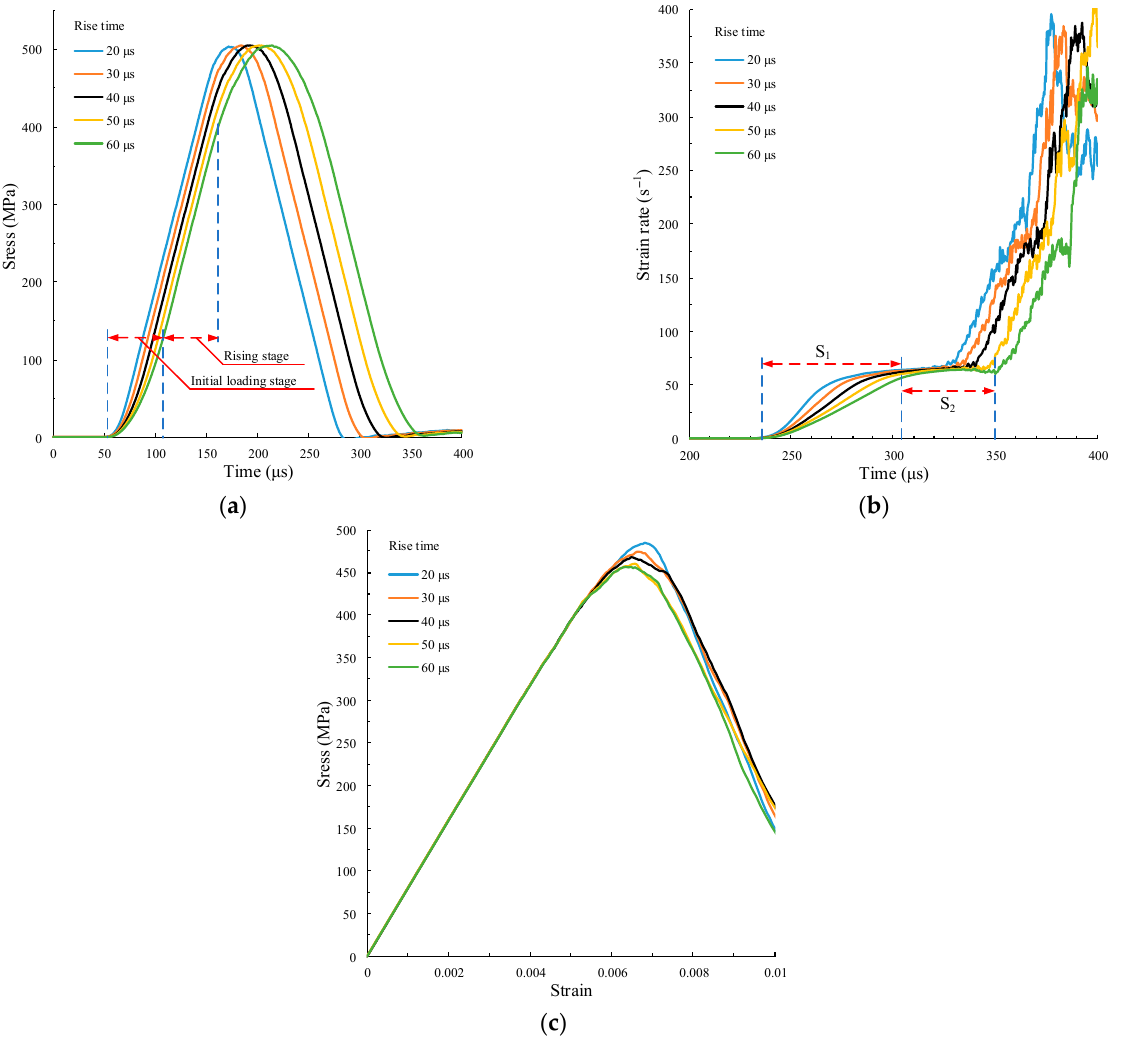
Figure 11. Curve calculations under different rise times. ( a ) Time history curves of incident stress wave; ( b ) time history curves of strain rate; ( c ) stress–strain curve.